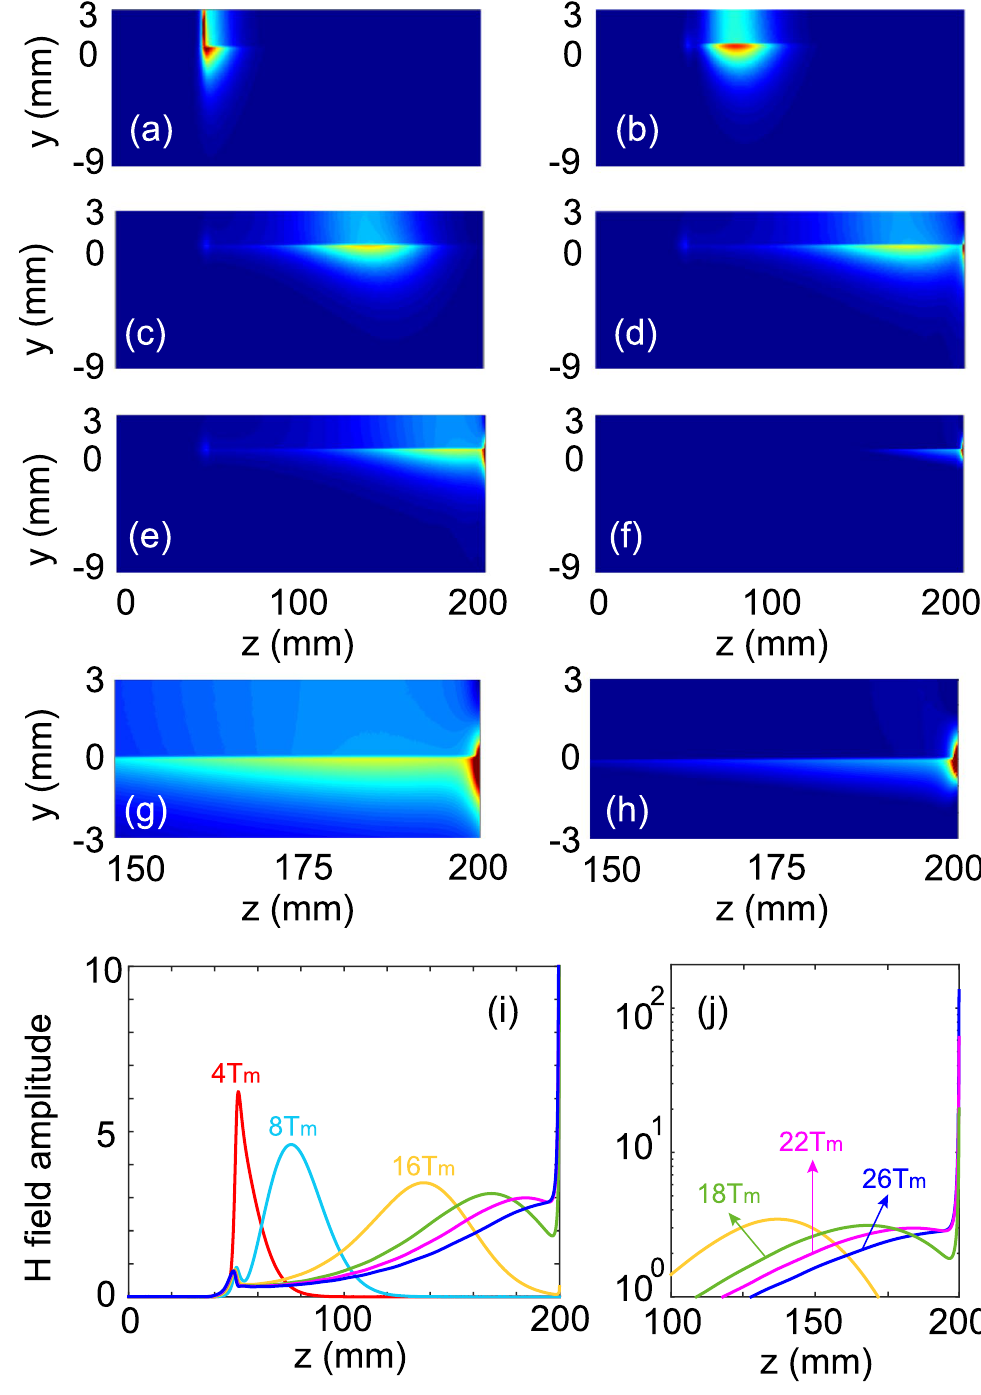
Figure 7. FDTD simulated H amplitudes at different evolution times. ( a ) 4 T m ( I m = 1), ( b ) 8 T m (when the excitation finishes), ( c ) 16 T m , ( d ) 18 T m , ( e ) 22 T m , and ( f ) 26 T m . ( g , h ) Close-up views of local regions in ( e ) and ( f ). ( i , j ) Distributions of H amplitude on the YIG surface along the z axis for the various evolution times. The linear current source is placed at z = 50 mm and y = 1.5 mm, and its parameters are τ = 1.3 T m , t 0 = 4 T m , and f c = 6.25 GHz. The loss coefficient is ν = 10 − 3 for YIG, and the other parameters are the same as in Fig.